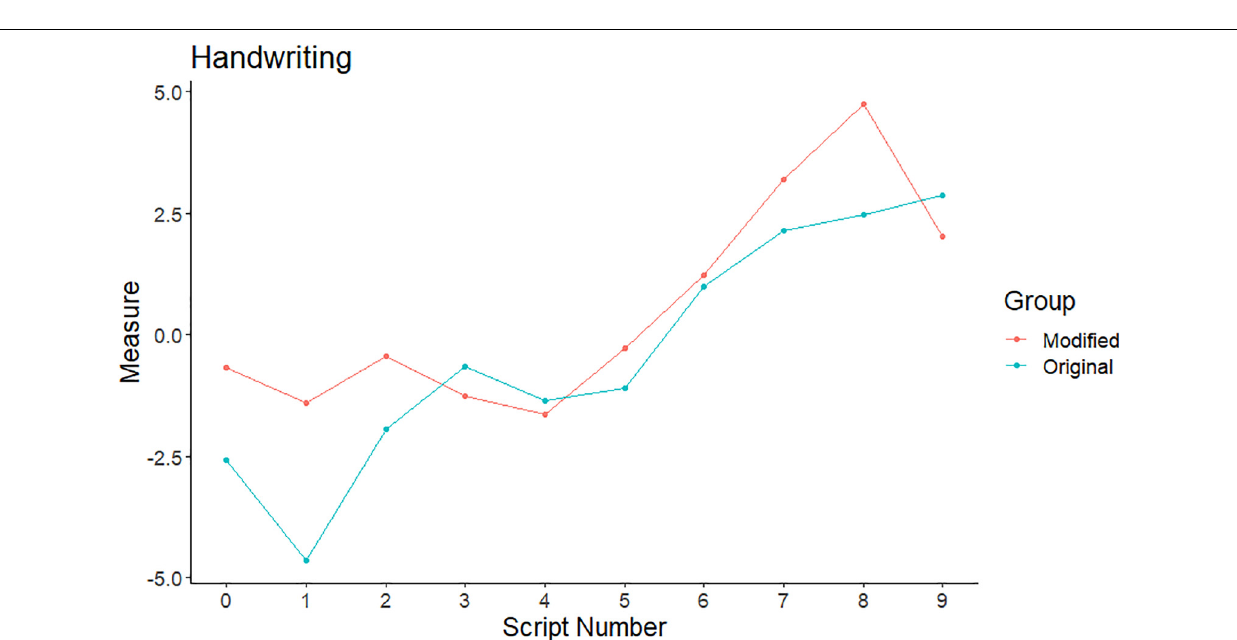
FIGURE 2 | Comparative judgment (CJ) measures for the original and modified script variants: appearance.